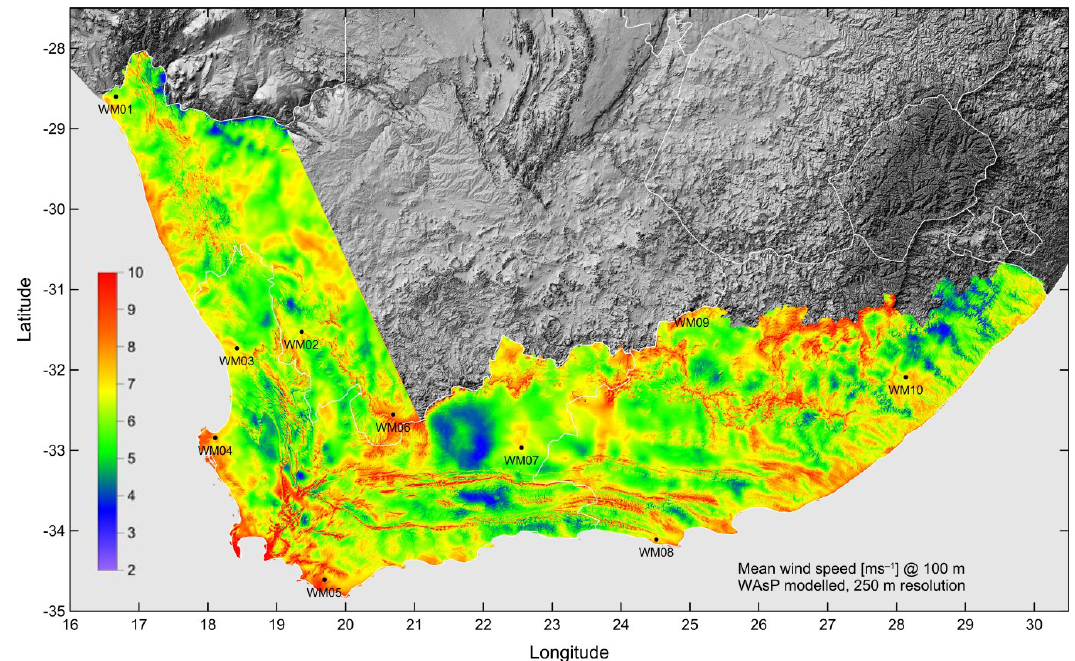
Figure 9. Wind map developed by Wind Atlas for South Africa (WASA)